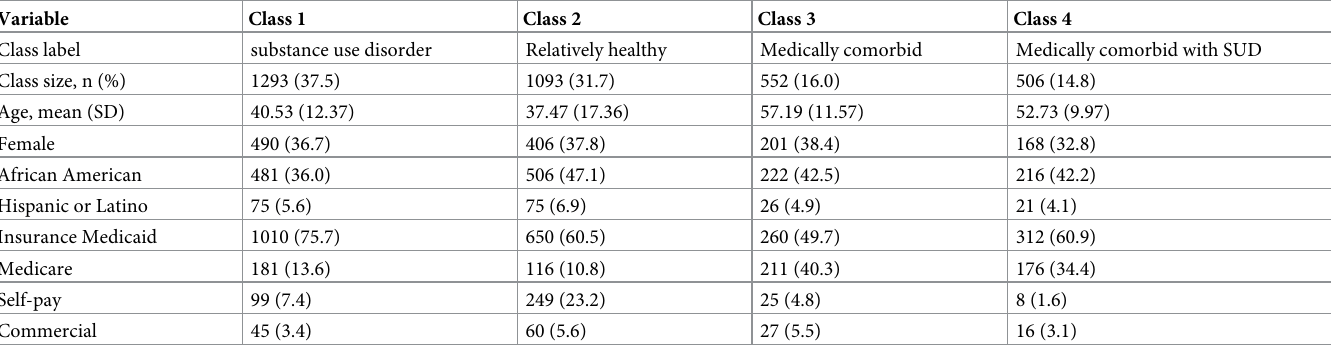
Table 2. Summary of background characteristics of homeless patients in four latent classes. The values are count and percent unless otherwise noted.